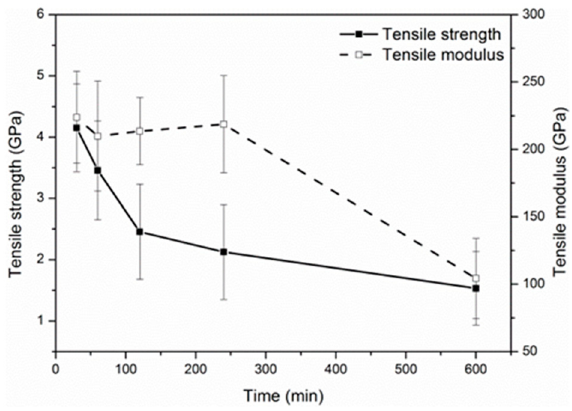
Figure 4. Effects of exposure time at 500 °C on the mechanical properties of single carbon fibers.